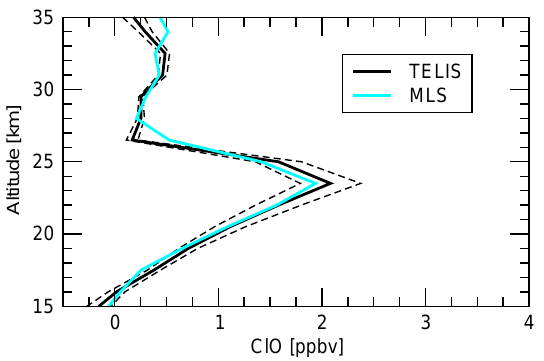
Fig. 7. The retrieved ClO vertical profile in ppbv from the TELIS balloon flight on 24 January 2010 in chlorine activated Arctic air. ClO is a member of the active chlorine chemical family and the peak in the profile around 23km is because of the conversion of inactive reservoir chlorine into active chlorine. The retrieved pro- file by TELIS is given in black and the dashed lines refer to the estimated overall accuracy of this profile. The profile by the MLS satellite instrument is given in blue.